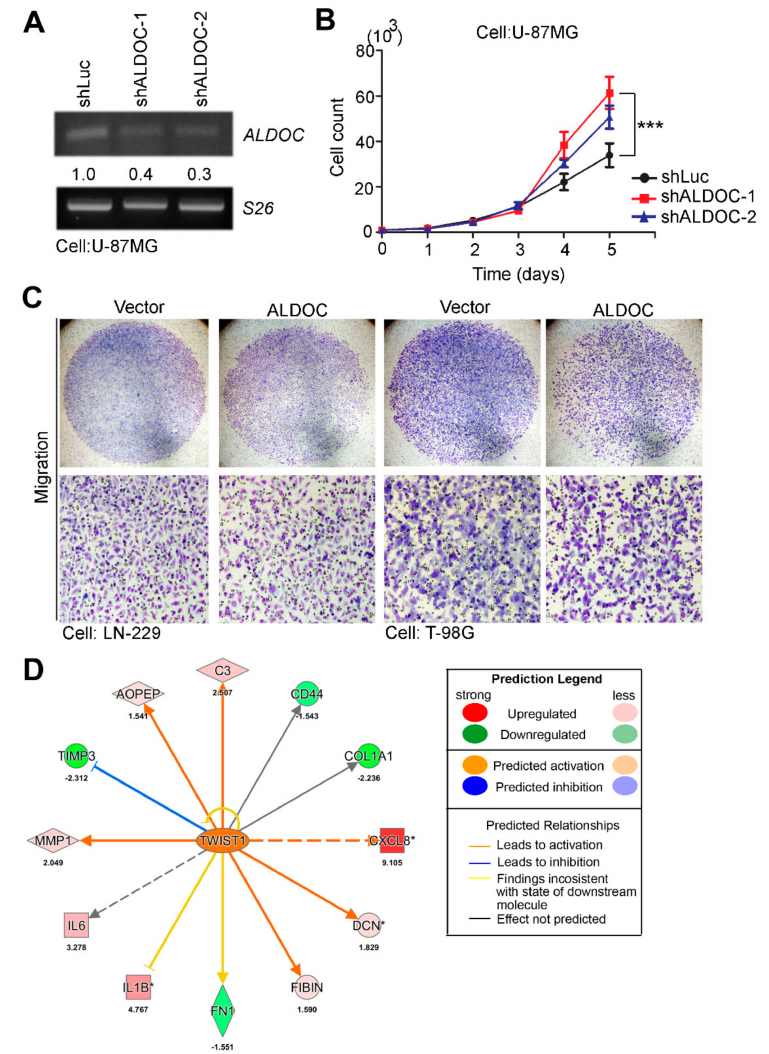
Figure 7. ALDOC is involved in proliferation rate and metastatic ability of glioblastoma cells. ( A ) RT-PCR analysis of ALDOC mRNA expression of the ALDOC knockdown models in U-87MG cells. ( B ) Trypan blue assay to measure cell viabilities of the ALDOC knockdown models in U-87MG cells. ( C ) Representative Giemsa staining to estimate the migration abilities of LN-229 and T-98G cells with forced expression of the vector control or exogenous ALDOC gene, respectively. ( D ) The network was predicted using the common signature that was overlaid with microarray data from U-87MG shALDOC cells with a 1.5-fold change cut-o ff in the IPA database. (*** p <